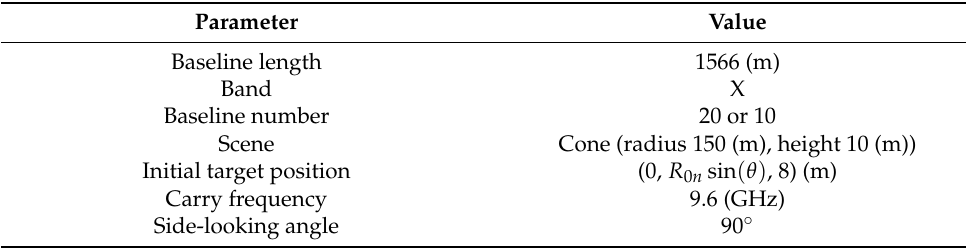
Table 2. Radar parameters.